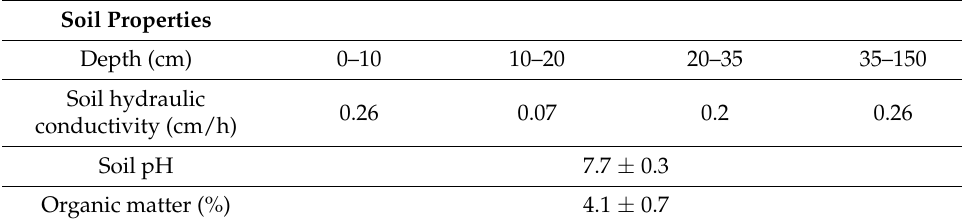
Table 1. Some soil Properties at Londesborough field site.